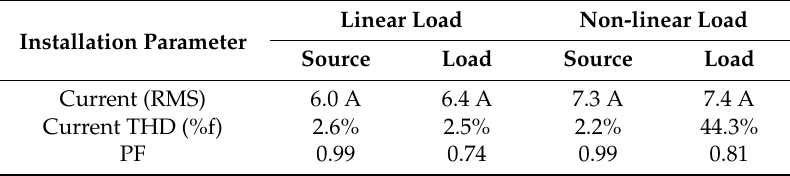
Table 3. Comparison of experimental results of the RMS, THD and PF values of the load current and source current with SAPF compensation, for operation with linear and non-linear